Question: Provide a one-line summary of what is displayed.
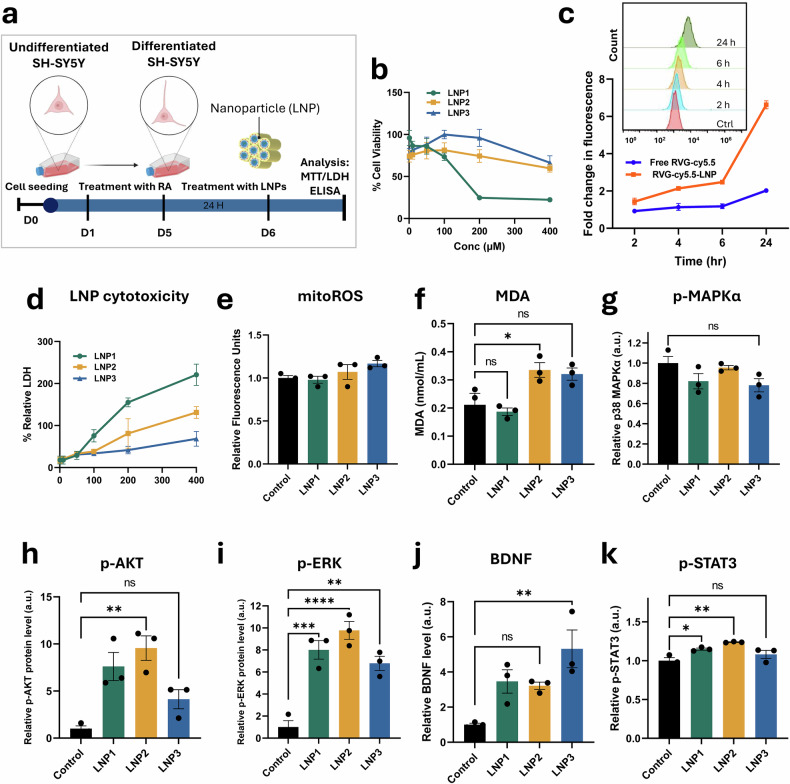
Answer: In vitro cellular studies of liquid crystalline lipid nanoparticles in differentiated SH-SY5Y cells, validating the fundamental design principles of the LNPs. a Experimental treatment scheme of SH-SY5Y cells after differentiation with retinoic acid (RA) for 5 days and incubation with LNP formulations (LNP1, LNP2, LNP3) for 24 h in FBS-free medium. This treatment was followed by assays for viability, cytotoxicity, mitochondrial oxidative stress, and signaling pathway activation. b Cell viability (MTT assay) of LNPs in a dose-dependent manner (1–400 μM). c Cellular uptake kinetics of RVG-Cy5.5–conjugated LNPs vs free Cy5.5 dye measured by flow cytometry, showing enhanced, time-dependent uptake of RVG-Cy5.5–LNPs. d cytotoxicity (LDH release) of LNPs (1–400 μM). e – k In vitro assessment of oxidative stress markers (MDA) and mitochondrial oxidative stress markers (mitochondrial ROS detected by MitoSOX Red) and survival/neurotrophic signaling markers (p-AKT, p-ERK, p-STAT3 Tyr705, p-MAPKα, and BDNF) following LNP treatment. The data are reported as the mean ± SD ( n = 3; * p < 0.05, ** p < 0.01, * ** p < 0.001, **** p < 0.0001)